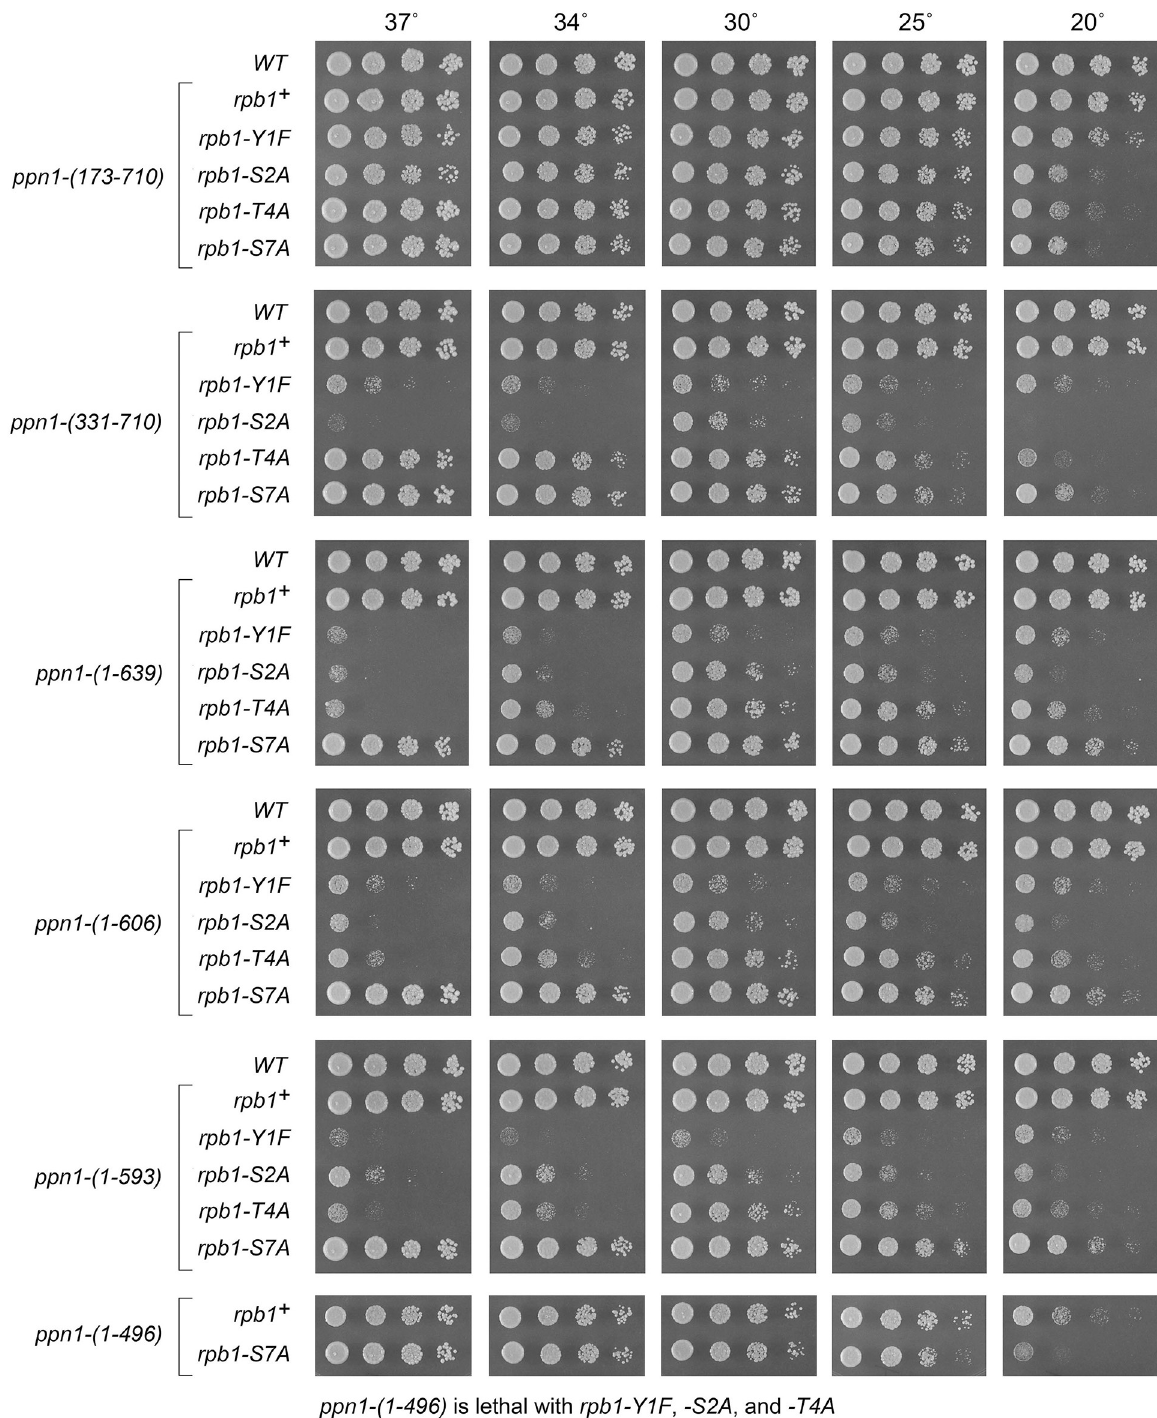
Fig 6. Activity of Ppn1 truncations in CTD mutant backgrounds in which Ppn1 is essential. S . pombe strains bearing the indicated ppn1 truncation alleles in combination with rpb1-CTD phospho-site mutants were spot-tested for growth on YES agar at the indicated temperatures. The ppn1-(1–496) allele, which did not complement the cs growth phenotype seen in ppn1 Δ , was lethal in the rpb1-Y1F , - S2A , and - T4A backgrounds.